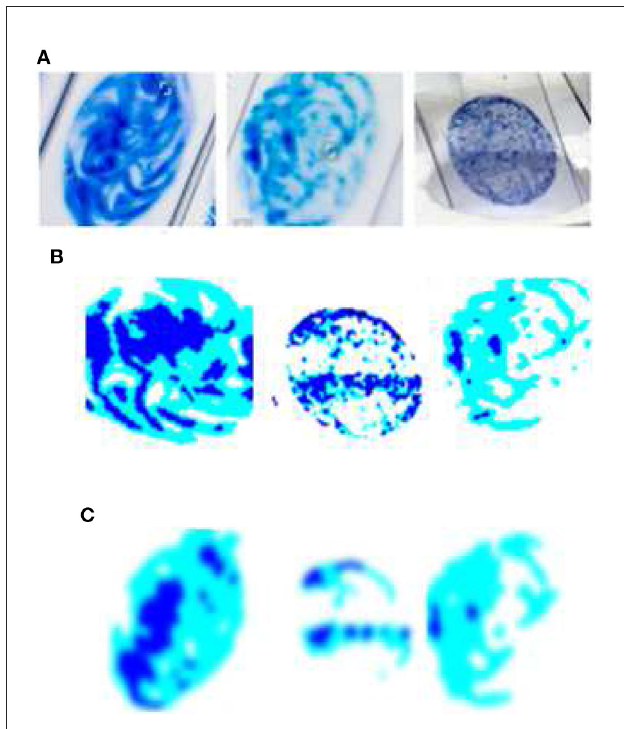
FIGURE2 Sample of original image and the enhanced image after the application of pre-processing techniques. (A) Relevant data identification using ROI extraction; the most important features which aid identification are extracted. (B) Foreground data; extraction of the foreground of an image for further processing. (C) Image enhancement (IE) using Gaussian filter; IE due to random changes in intensity, lighting fluctuations, or insufficient